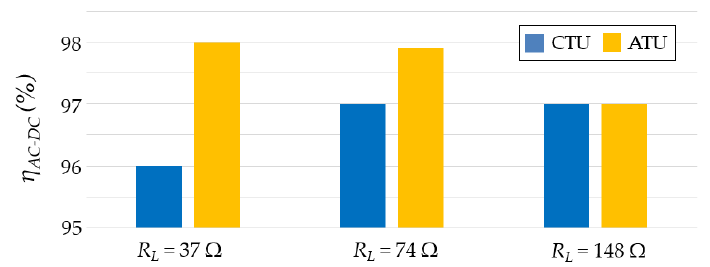
Figure 14. Comparison of AC–DC conversion efficiency computed under different load condi- tions.